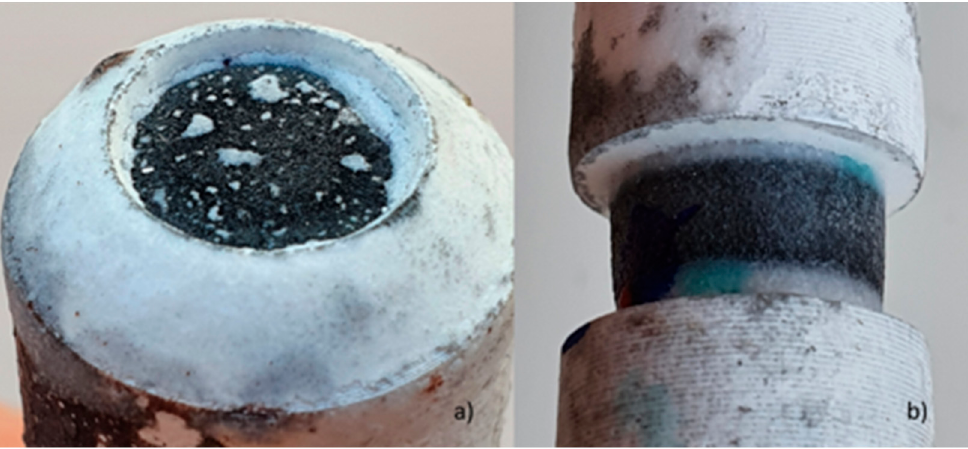
Figure 13. Images of anodes after experiment: ( a ) horizontal anode and ( b ) vertical anode.